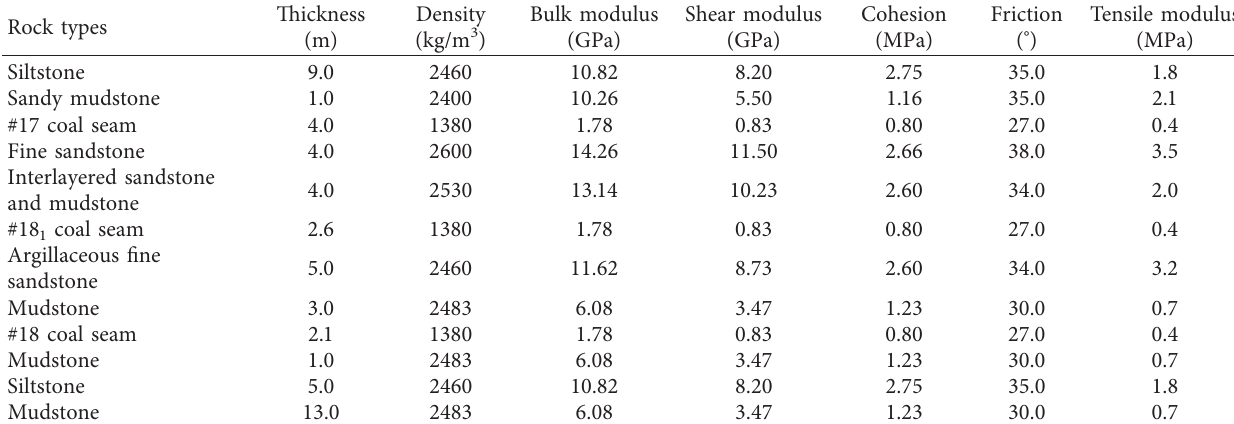
Table 1: Physical parameters of the rock